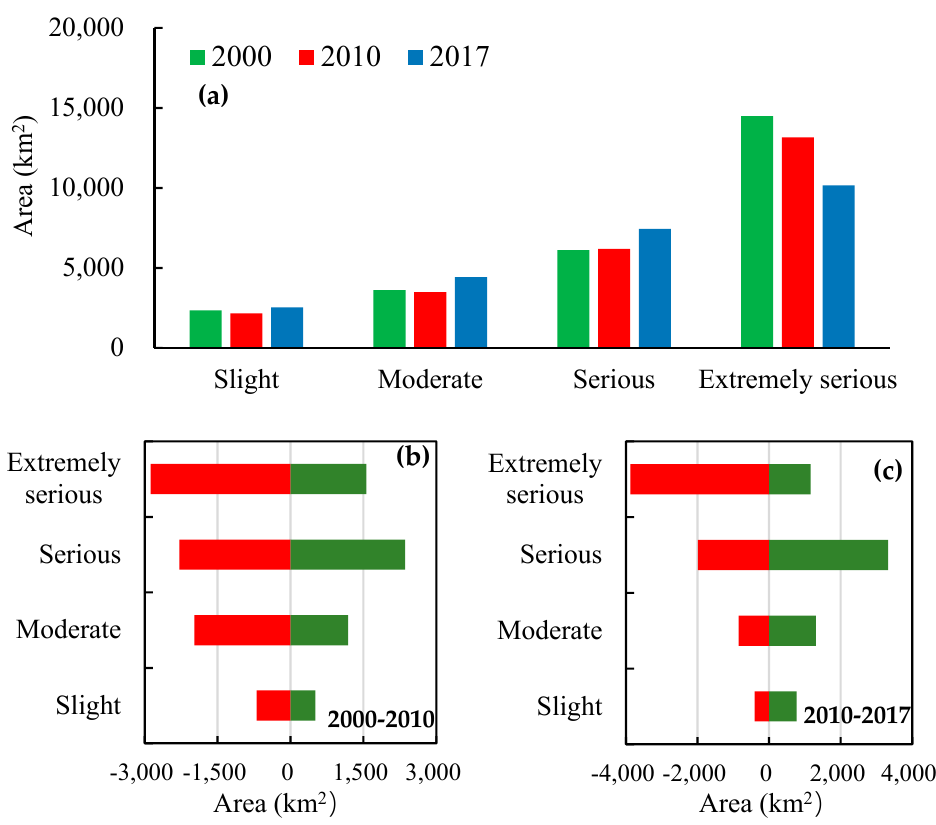
Figure 4. The area of different salinized soil grades in different periods ( a ) and the area variation of different salinized soil grades during 2000–2010 ( b ) and 2010-2017 ( c ). Figure 5 shows the relative change of salinized soil area in different counties of the study area. From 2000 to 2010, the area of salinized soil in all counties decreased in varying degrees, and the area of salinized soil in Zepu county where is a non-oasis region decreased the most, with a relative change rate of 100%. The decrease degree of salinized soil area in Shache county was the largest in all plain oasis regions, whose relative change rate was − 12.59%. From 2010 to 2017, the originally improved soil salinization in the Yuepuhu county, Yingjisha county, Yecheng county, Shache county, and Maigaiti county during 2000 to 2010 rebounded, emerging a trend of deterioration. Among these, the area of salinized soil in the Yecheng county in the non-oasis area increased the most, with a relative change rate of 42.3%, followed by the Yuepuhu county in the oasis area with a relative change rate of 6.91%. On the contrary, the area of salinized soil in Kashgar city decreased the most in all counties with a relative change rate of −